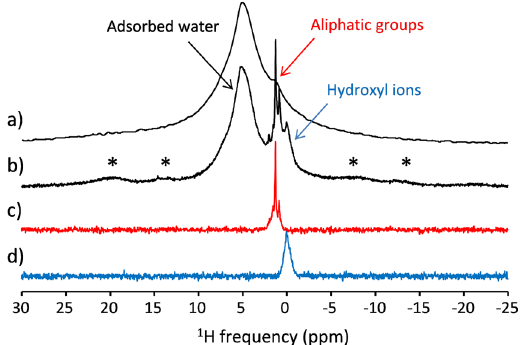
Figure 6. 1 H solid-state NMR spectra of the mouse tooth sample recorded at a magnetic field of 17.6 T ( a ) without sample spinning and ( b ) with MAS at a spinning frequency of 10 kHz. The asterisks indicate spinning sidebands. ( c , d ) 1 H MAS selective spin echo MAS spectra of the ( c ) aliphatic protons and ( d ) hydroxyl groups, recorded with an echo time of 5.4 ms and using a refocusing R-SNOB pulse of 3 ms duration (10 kHz spinning